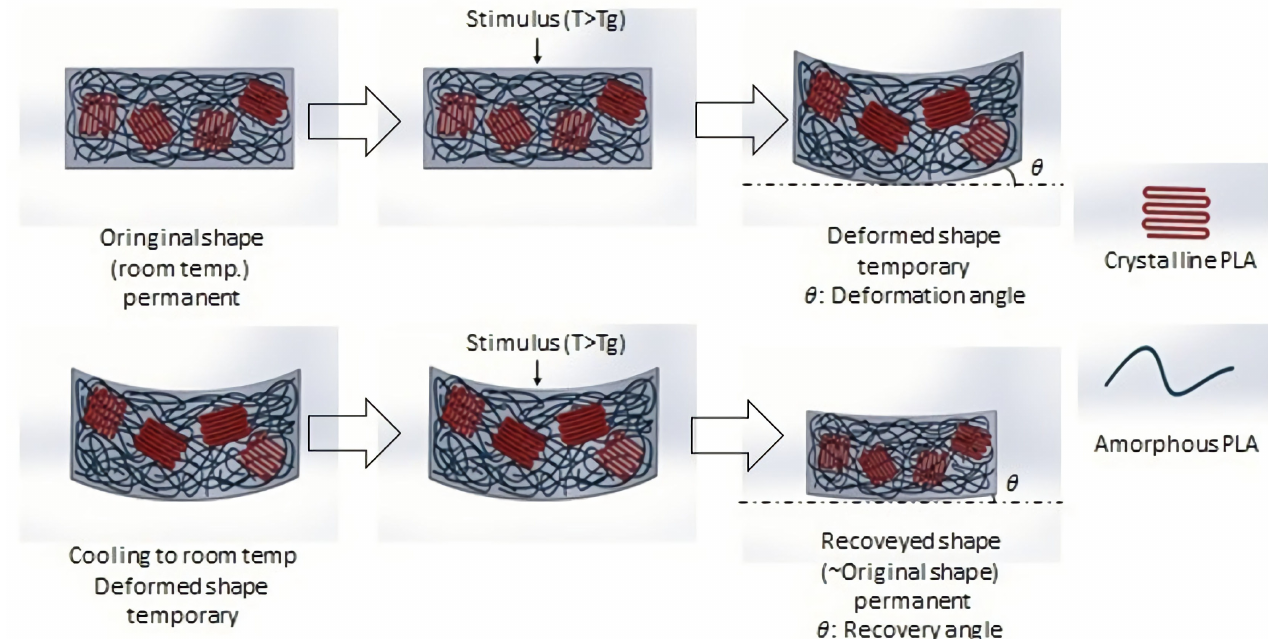
Figure 4. Shape memory mechanism of a stimulus-responsive composite